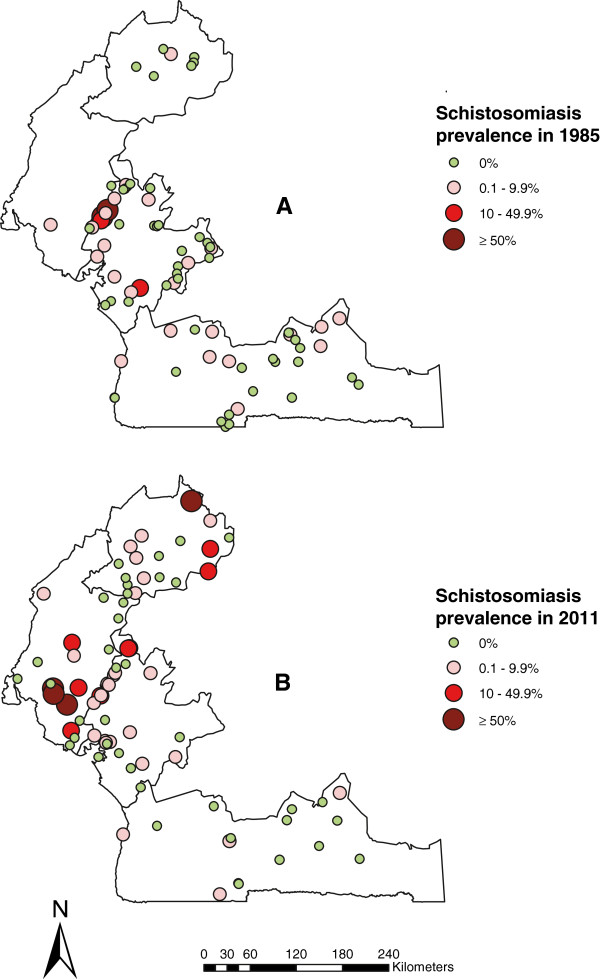
Comparative maps of the overall schistosomiasis prevalence in the four surveyed regions of Cameroon. Prevalence distribution in 1985–1987 (A) and in 2011 (B).